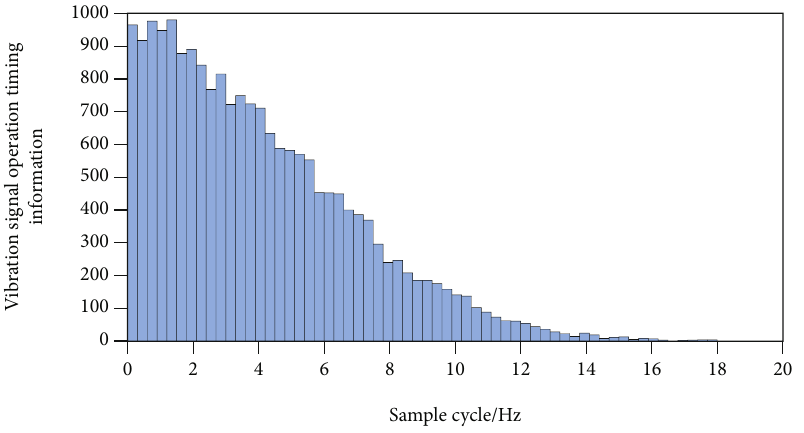
Figure 6: Statistical distribution of time sequence information of vibration signal